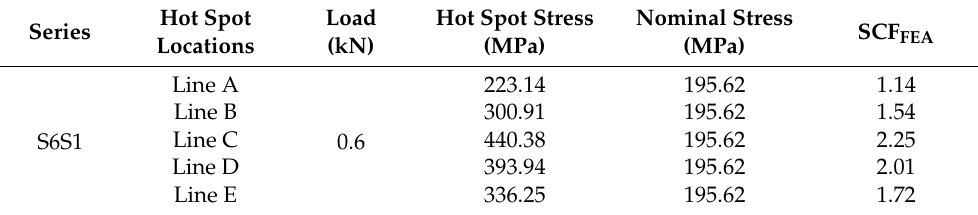
Table 6. Numerical SCFs of SHS-SHS T-joint specimens under out-of-plane